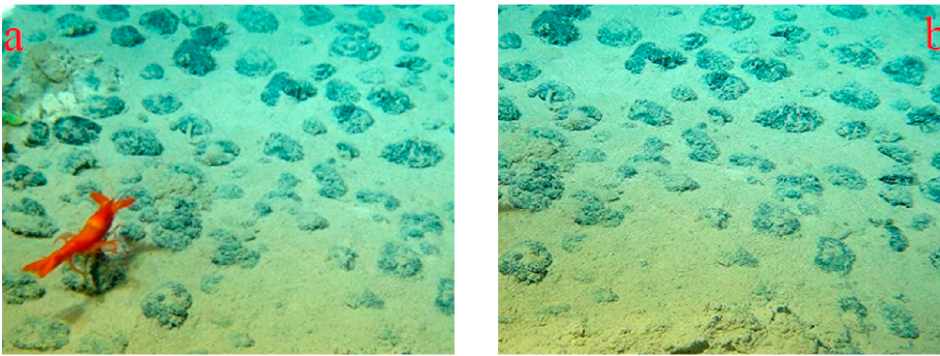
Figure 13. The improved images for T3: ( a ) Reference image; ( b ) Be-registered image.